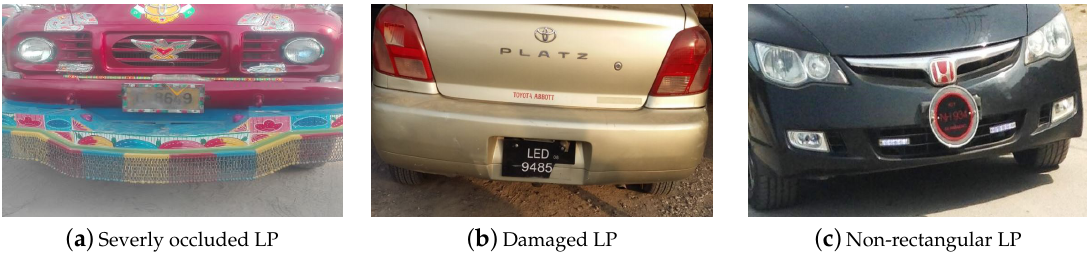
Figure 10. Vehicle images where LPs are not correctly segmented due to various reasons.